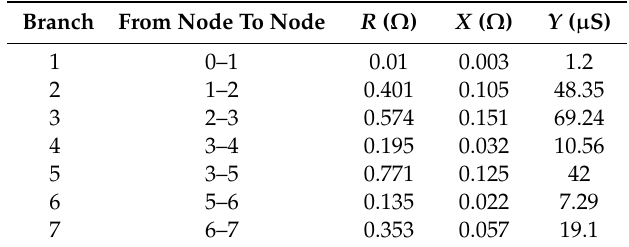
Table 4. Line parameters of the “MTL3” MV feeder.